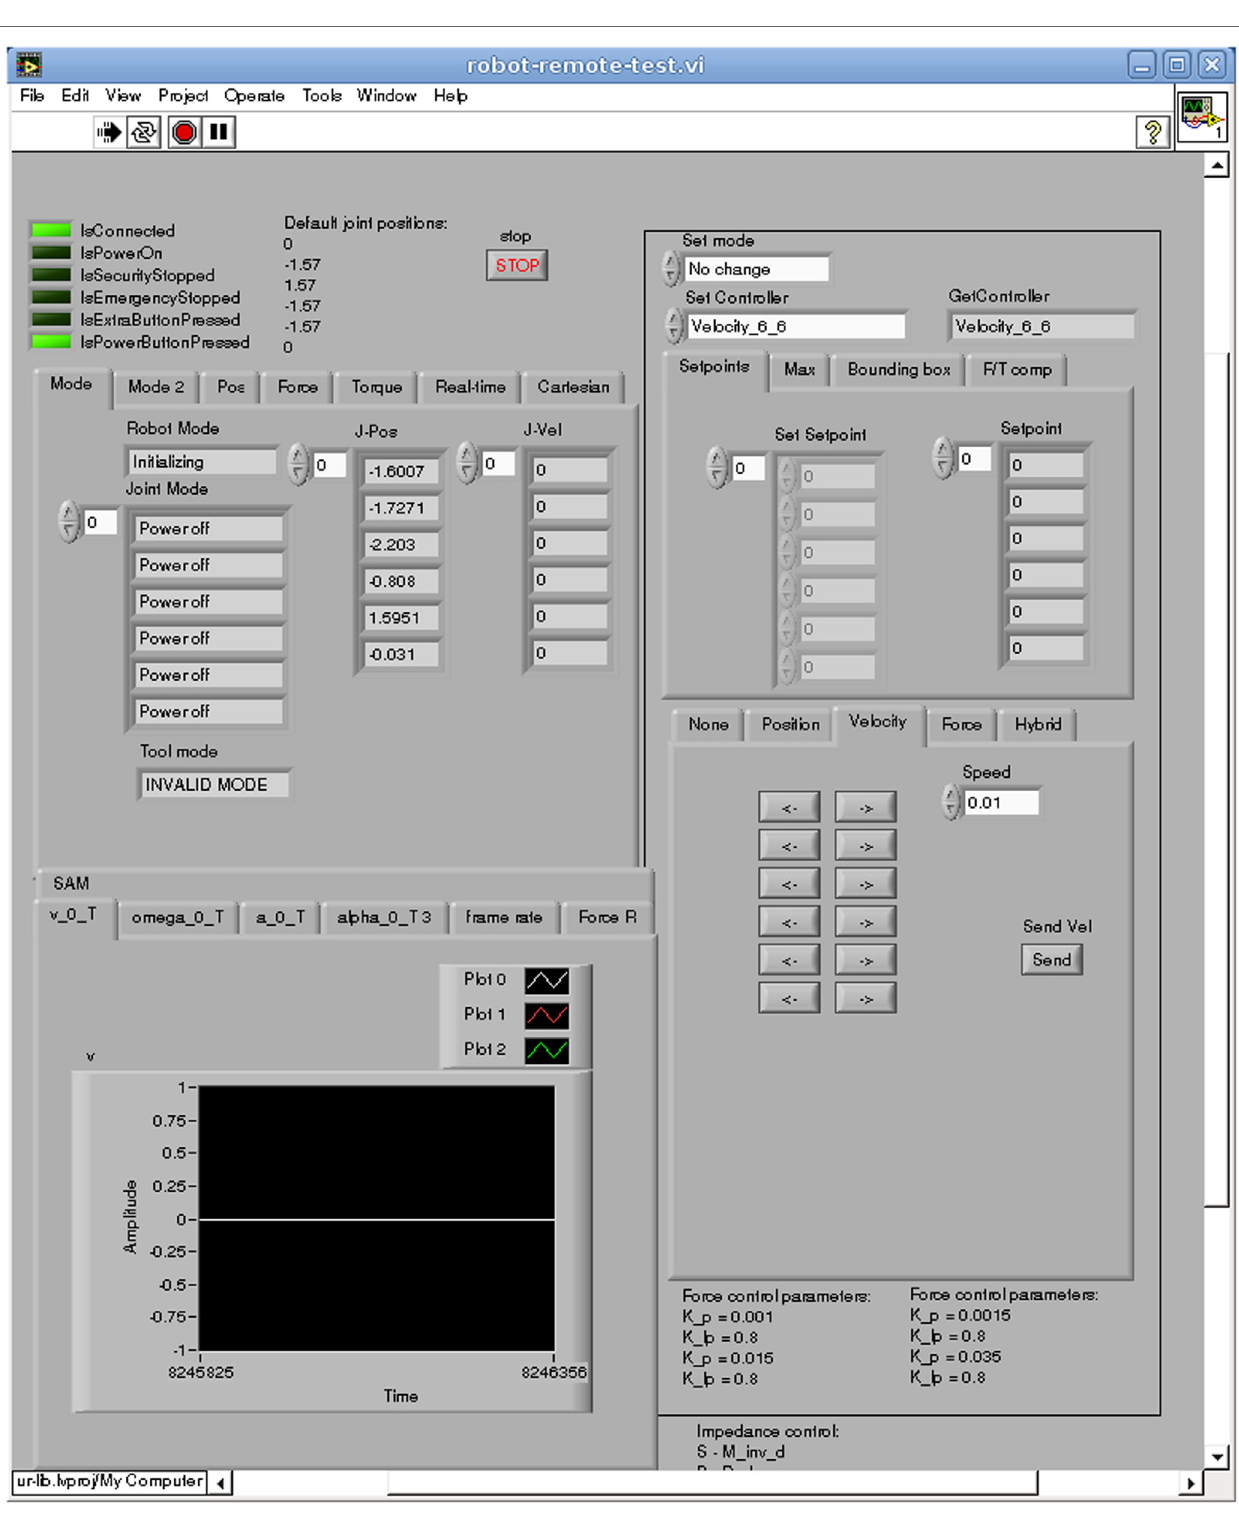
February 2016 | Volume 3 | Article 1